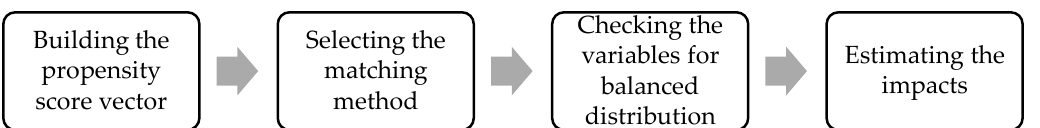
Figure 2. Diagram of the Propensity Score Matching procedure.